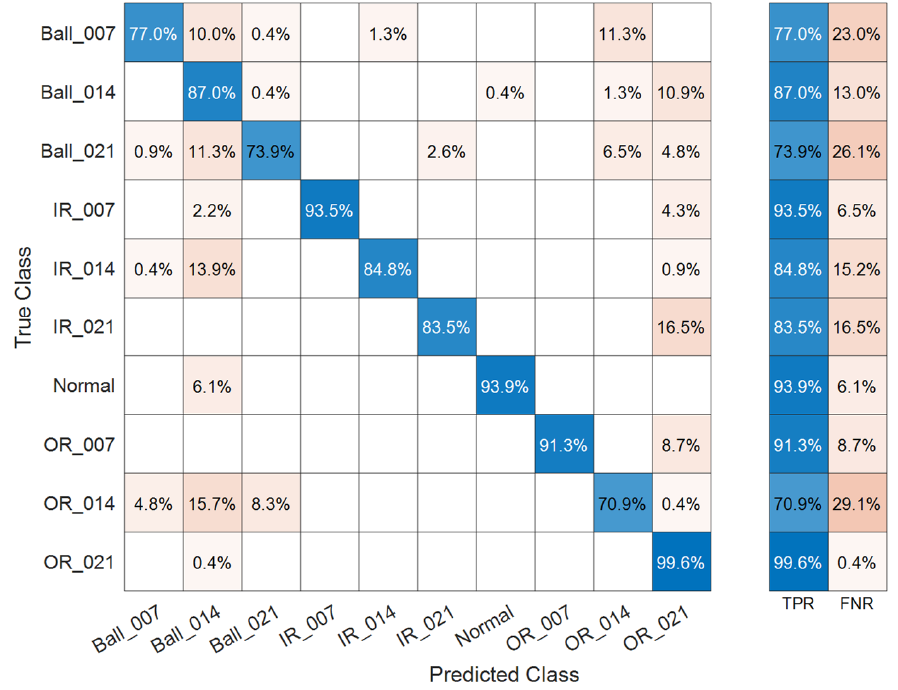
Figure 10. Confusion matrix of motor bearing failure prediction in fine Gaussian SVM on the noisy environment, with a total accuracy of 85.5%.